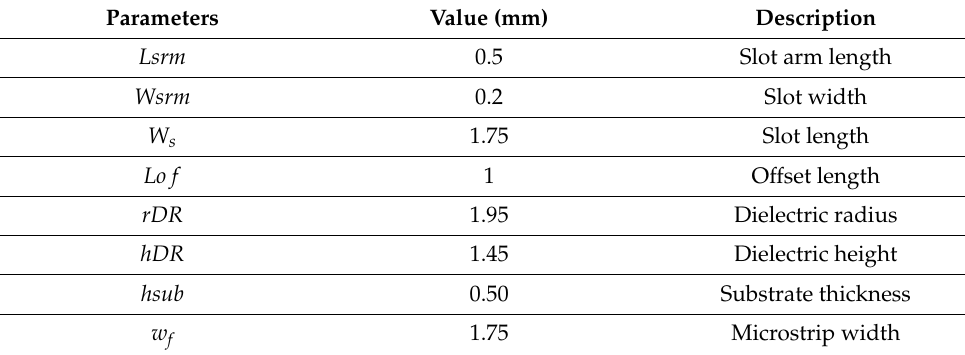
Figure 3. Magnetic field distribution of the resonant HEM 11 δ mode in the proposed single element CDRA obtained from an eigenmode solution. Table 1. Design parameters of the proposed single element CDRA.